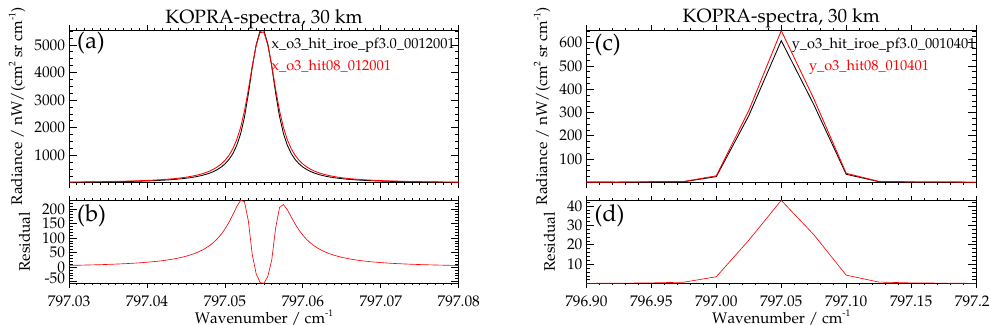
Figure 15. (a) Modelled spectral signature of the ozone line at 797.05cm − 1 for a limb observation with a tangent height of 30km using the MIPAS-pf3.2 (black) and the HITRAN-2008 spectroscopy (larger γ air , 0 ) (red), monochromatic lines. (b) Corresponding residual. (c, d) Same as on the left but lines convolved with the apodized instrumental line